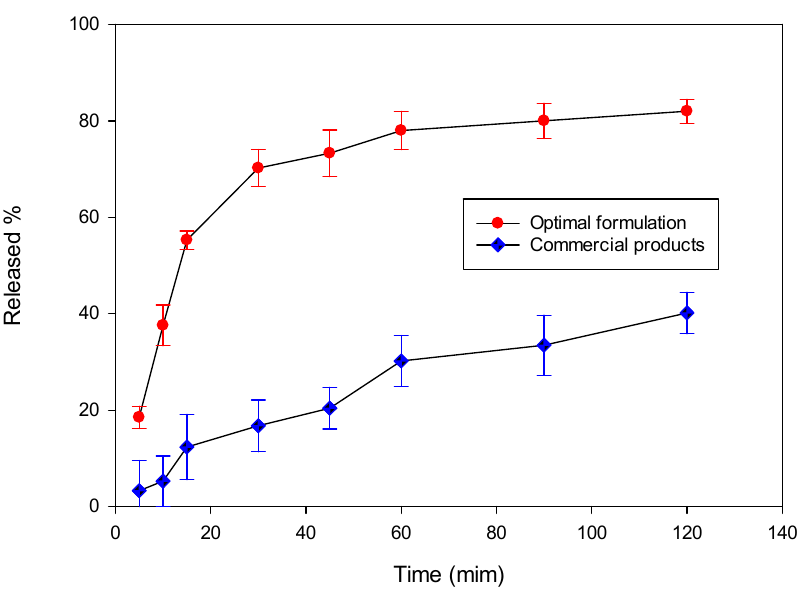
Figure 12. Dissolution curves of the optimal formulation FLL dropping pill and commercial Chinese patent